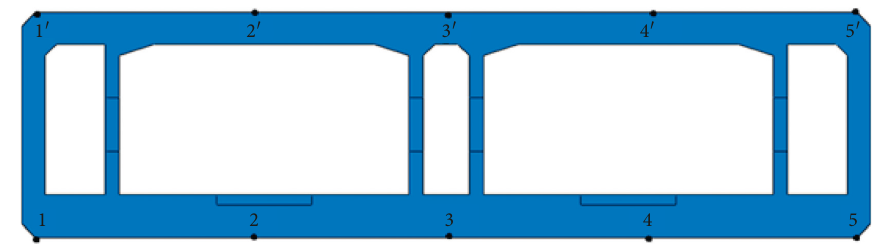
Figure 9: Nodes at the pipe joint interface.